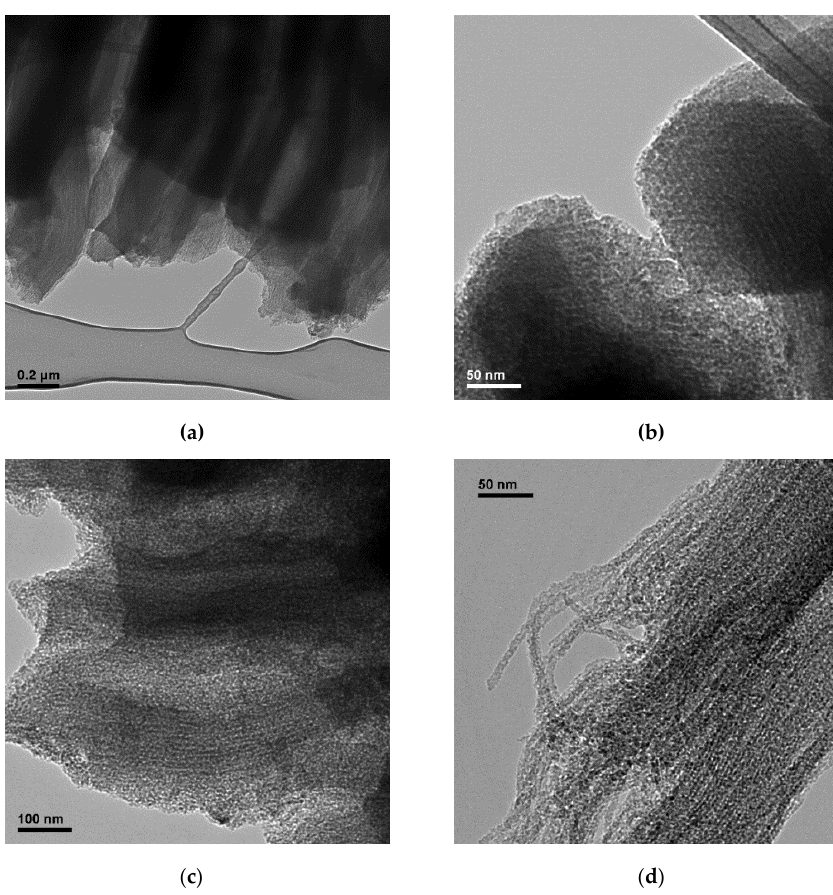
Figure 2. TEM images of ( a , b ) OMC-R2 and ( c , d ) OMC-R5HF.